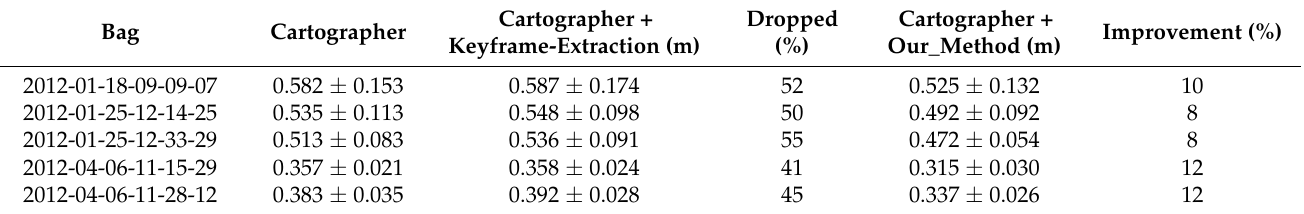
Table 1. RMSE values and percentage of dropped scans for Cartographer on MIT dataset. Cartographer Bag Cartographer